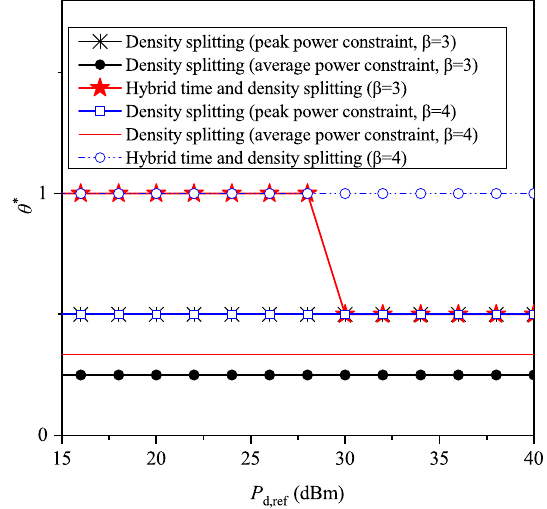
Figure 5. Optimized θ versus P d,ref for β = 3 and β = 4.